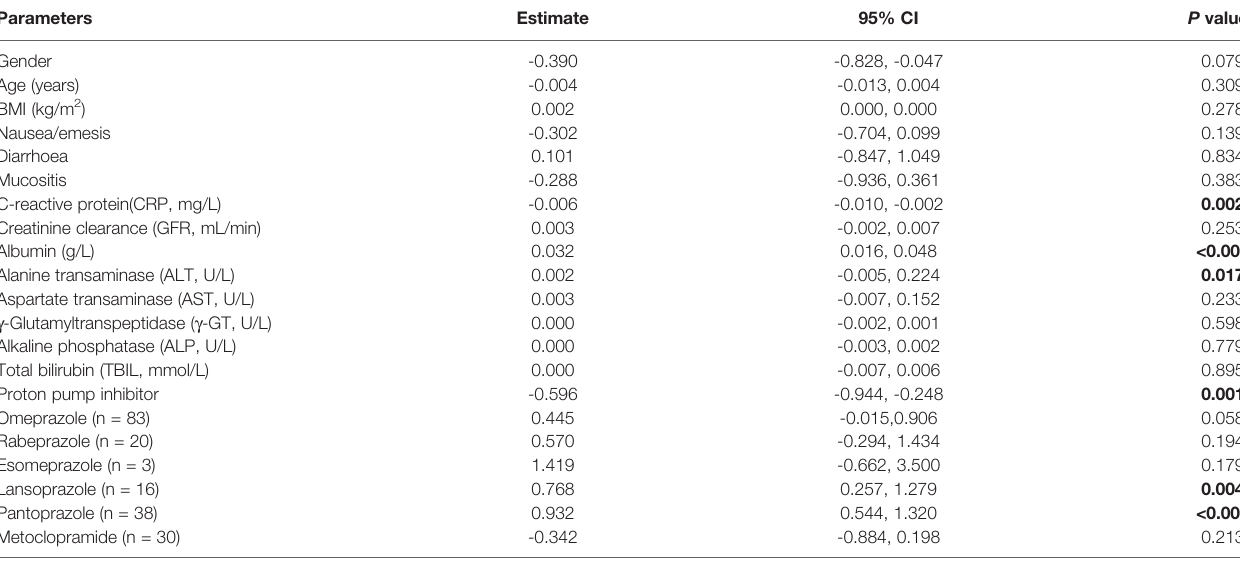
TABLE 3 | Univariate analysis of factors in fl uencing dose normalized plasma PCZ concentration.